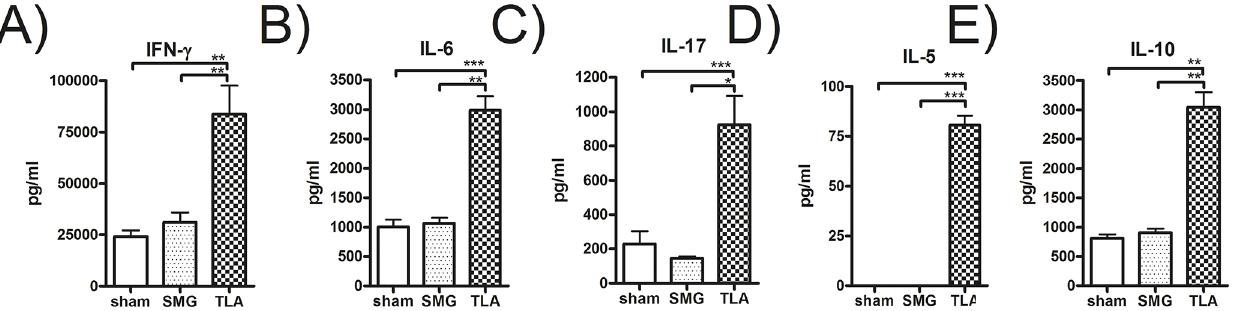
Fig 3. Cytokine production of splenocytes stimulated with TLA in vitro . After systemic vaccination and oral booster splenocytes were excised on day 34 and single cell suspensions were prepared and stimulated with TLA in vitro before cytokine levels were determined by ELISA. Results represent data of two independent experiments. Data are expressed as mean ± SEM. * p < 0.05; ** p < 0.01; *** p <